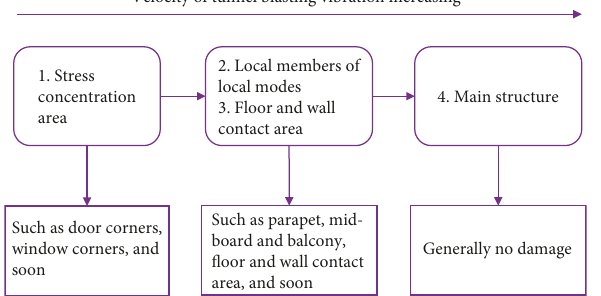
Figure 27: The sequence diagram of structural